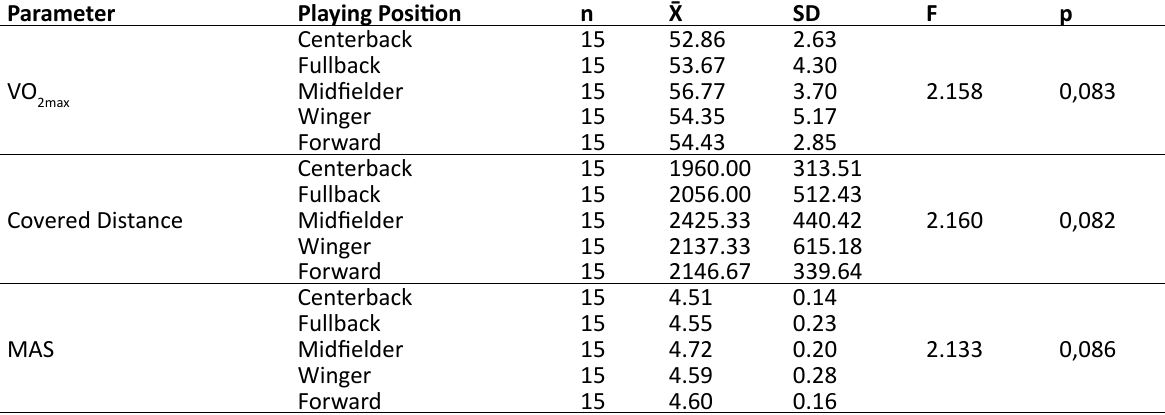
Table 3. The one-way anova results of VO young soccer players at different playing positions